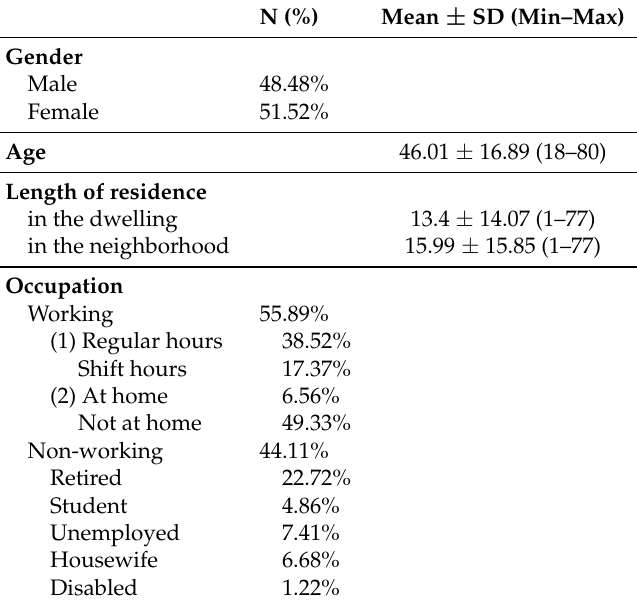
Table 2. Characteristics of the French study